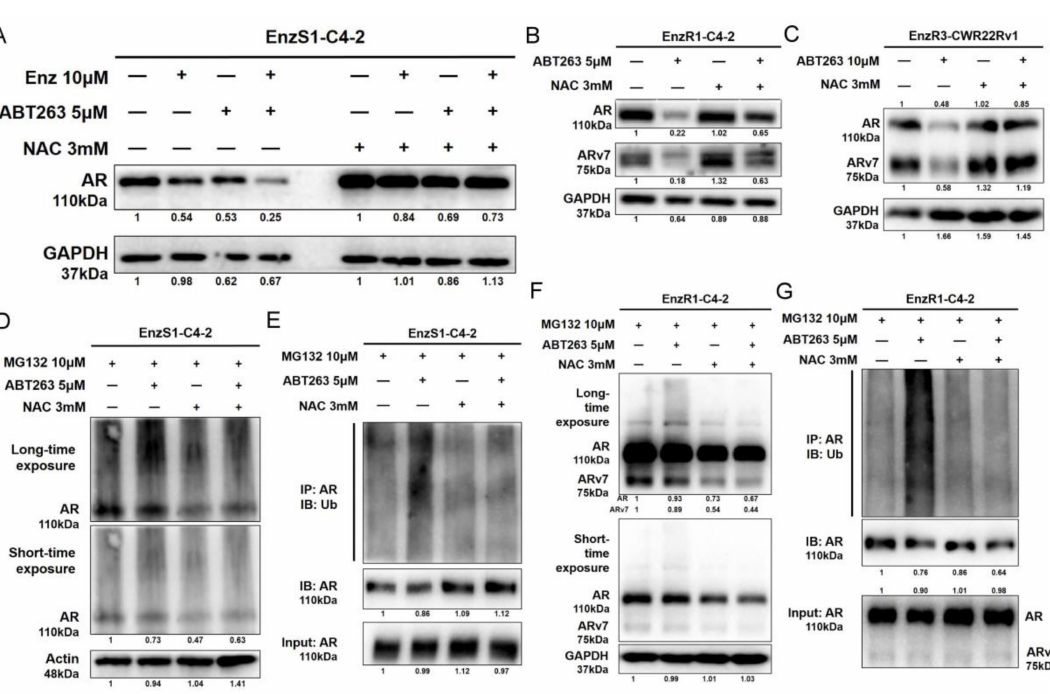
Figure 4. ABT263 increases AR / ARv7 degradation through inducing cellular ROS. ( A – C ) NAC reverses the ABT263 decrease of AR and ARv7 protein expression. Western blot assay was applied to measure AR and ARv7 expression in EnzS1-C4-2 cells ( A ), EnzR1-C4-2 cells ( B ), and EnzR3-CWR22Rv1 cells ( C ). ( D – G ) NAC reverses the ABT263 increased ubiquitination of AR and ARv7. Increased slower mobility species of AR in EnzS1-C4-2 and EnzR1-C4-2 cells upon ABT263 treatment could be reversed by NAC ( D , F ). Two exposures, short and long time, are shown. Note that the slower mobility species of AR is more visible with longer exposure time. Increased AR ubiquitination upon ABT263 treatment could also be reversed by NAC ( E , G ). Data are presented as Mean ±